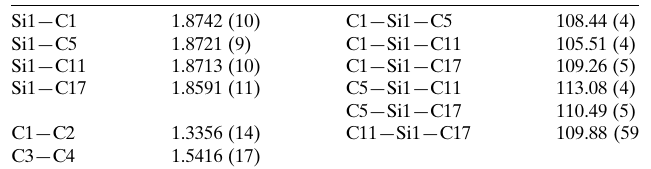
Table 2 Selected geometric parameters for compound 2 (A˚ , (cid:2) ).